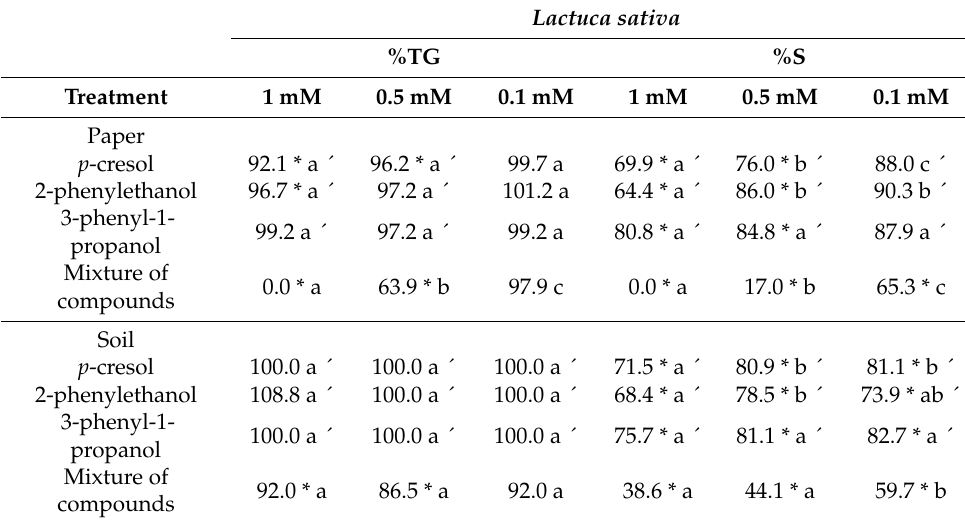
Table 2. Effect of different concentrations of phenolic compounds from the Cistus ladanifer exudate on Lactuca sativa germination (%TG) and germination rate (%S), expressed as the percentage relative to the control. Four replicates of each treatment ( n = 4 × 50 = 200 seeds in total for each solution). Lactuca sativa